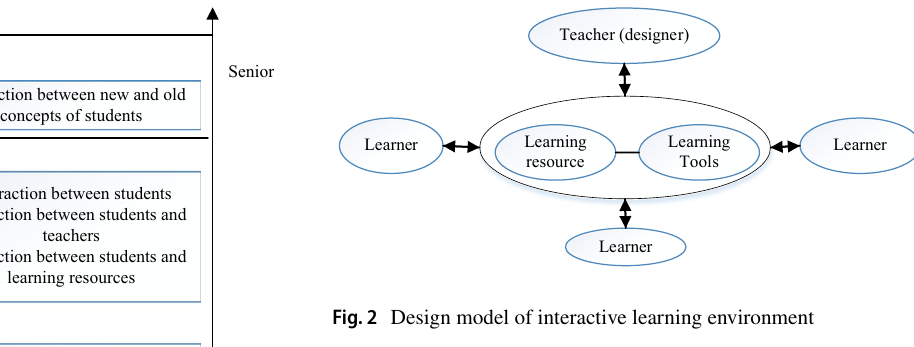
Fig. 2 Design model of interactive learning environment